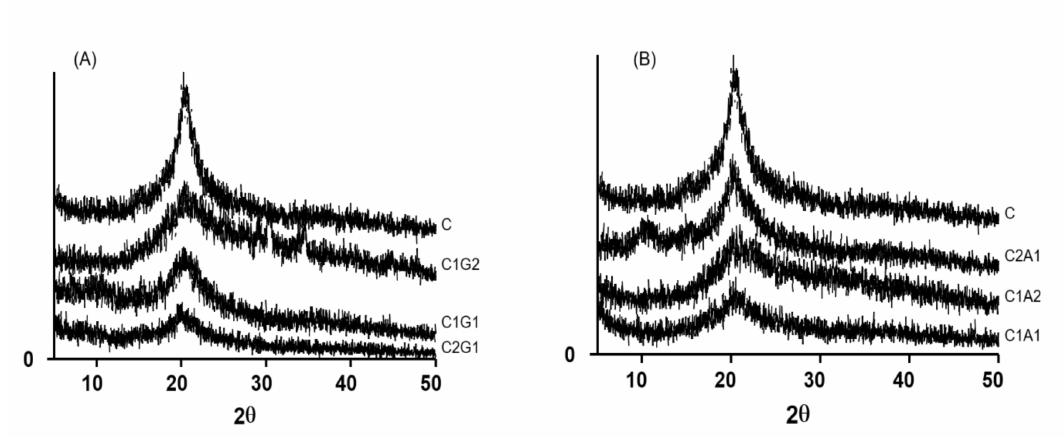
Figure 6. X-ray di ff raction patterns of chitosan and polyelectrolyte complexes SAH, based on chitosan / xanthan gum ( A ) and chitosan / alginate ( B ). C—Chitosan; C1G1—Chitosan:Xanthan gum